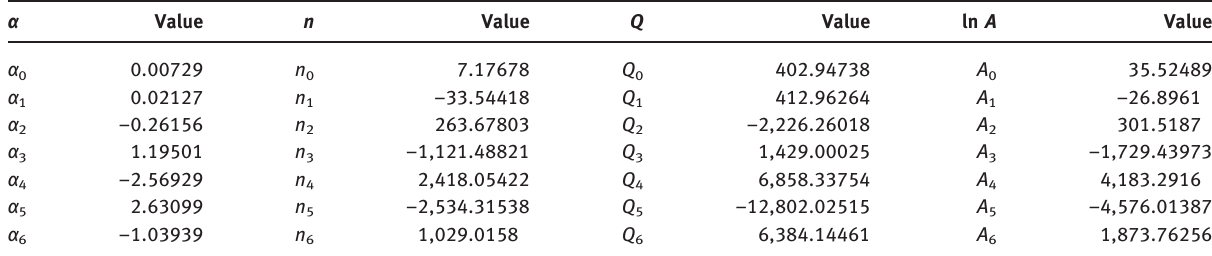
Table 2: Value of the coefficients in eq.